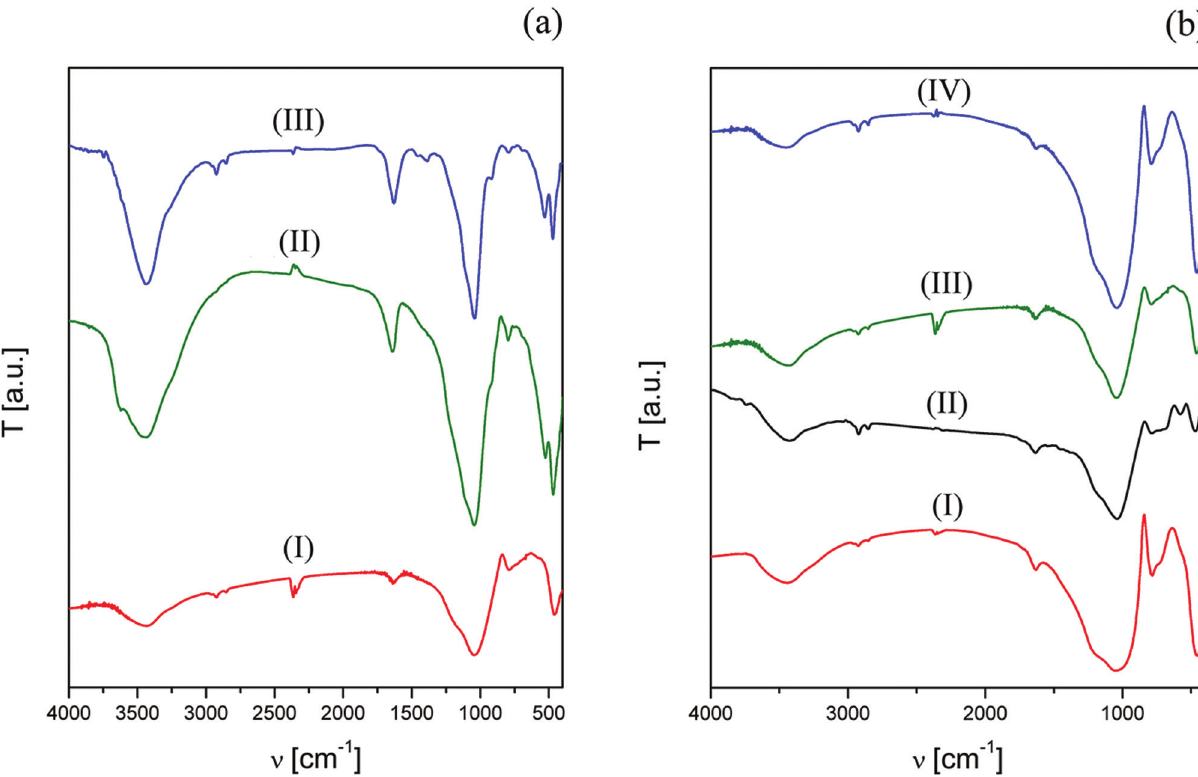
Figure 3: FT-IR comparative spectra of: (a) (I) K-10, (II) K-30, and (III) natural volcanic ashes; (b) (I) PVA 100, (II) PVA 40-100, (III) 40-60, and (IV) PVA